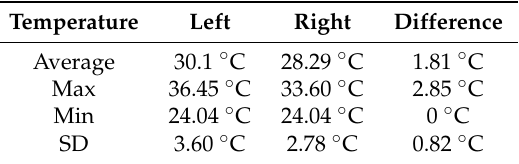
Figure 18. Case 3: ( a ) original acquired thermogram; ( b , c ) lower limit detection; ( d ) second degree polynomials; ( e ) right; and ( f ) left segmented breasts. Table 6. Statistical values of the temperatures of the segmented left and right breast areas and difference estimation for Case 4.